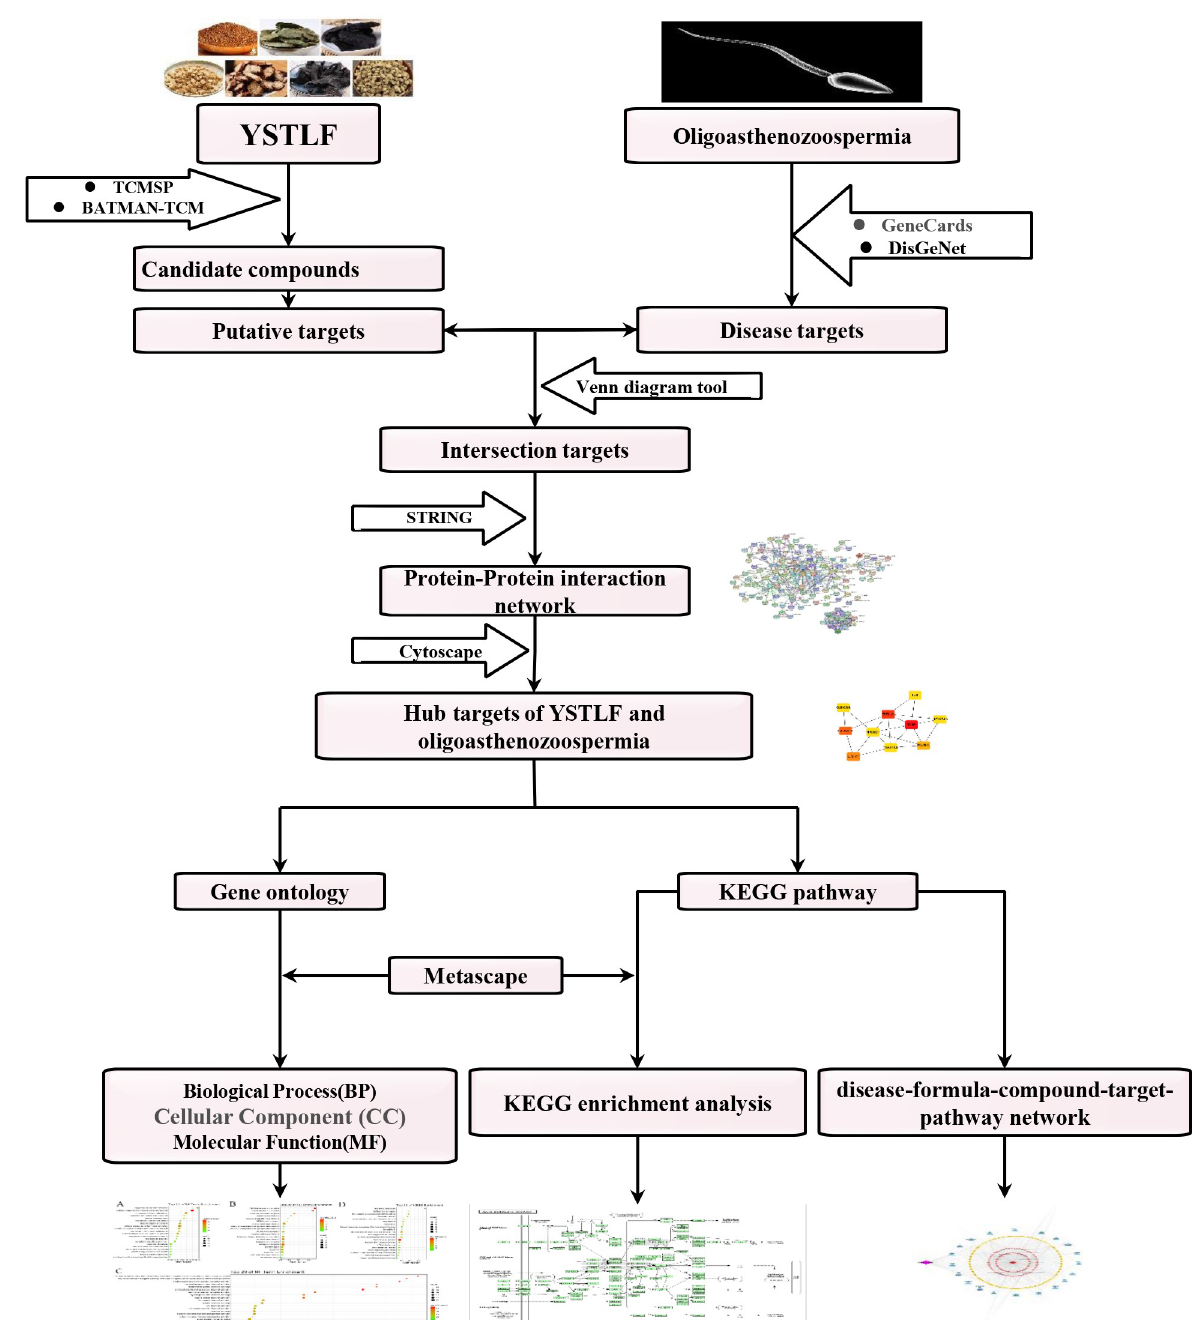
Fig 1. Workflow for elucidation of YSTLF in the treatment of oligoasthenozoospermia.